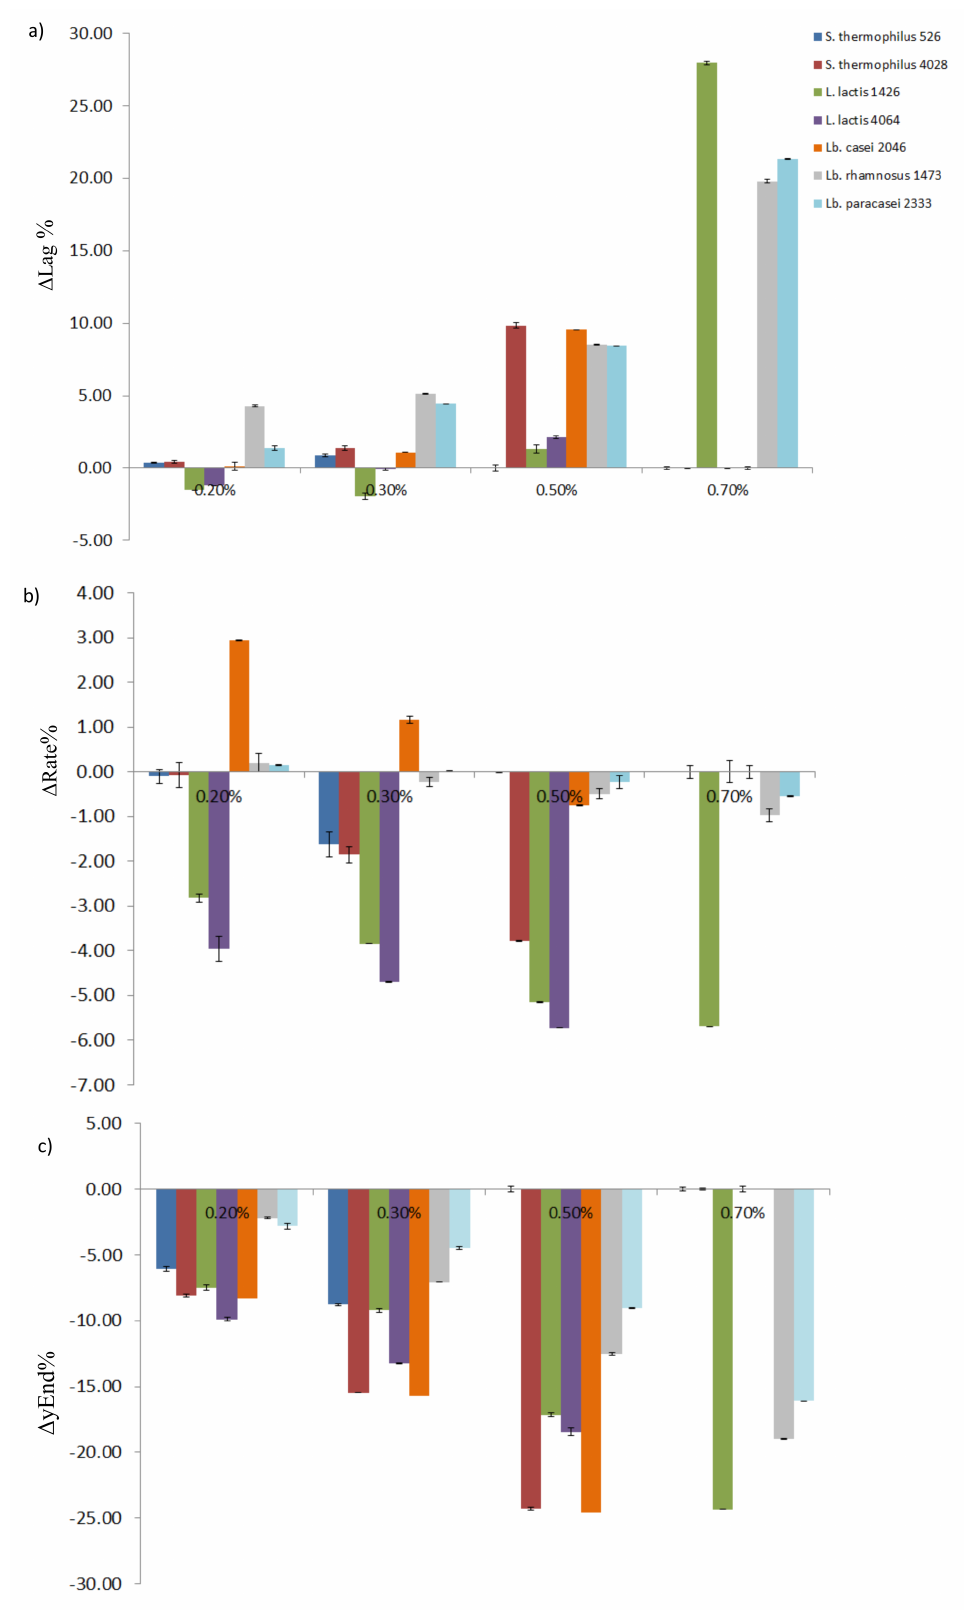
Figure 2. Graphical representation of the ∆ values of each parameter calculated as the difference from the control value 0%. In the figure: ( a ) ∆ Lag; ( b ) ∆ Rate; ( c ) ∆ yEnd. On the X-axis, the spirulina extract concentrations are reported: 0.20%, 0.30%, 0.50%, and